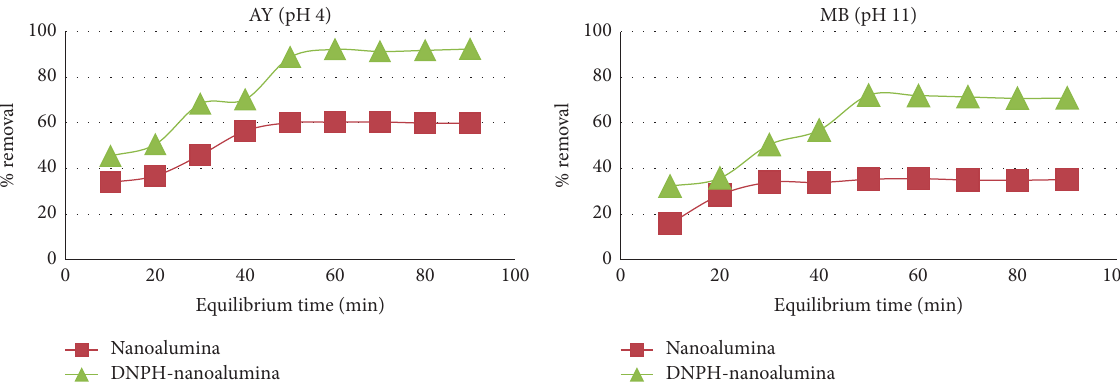
Figure 10: Equilibrium time for the removal of dyes, 50 mg/L dye concentration, 298 K, and 0.05 g adsorbent.